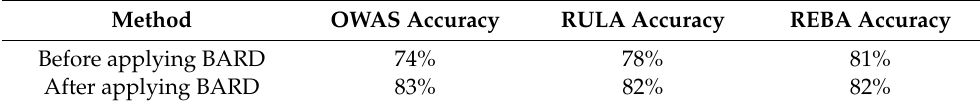
Table 5. Evaluation and comparison of accuracy of occluded posture.